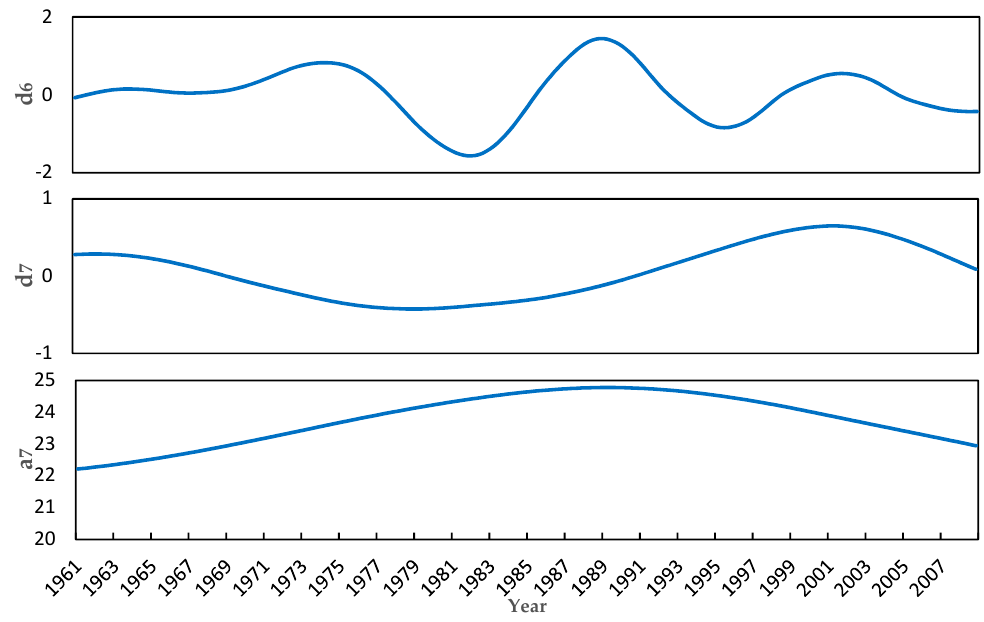
Figure 3. Modes of wavelet decomposition for STII time-series (First 240 months).